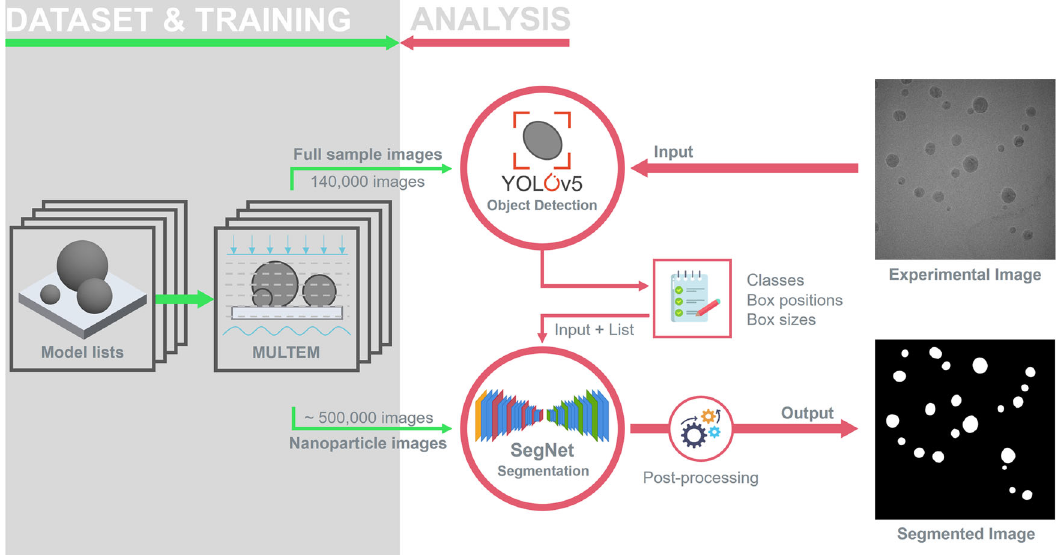
Fig. 1 Work fl ow illustrating the training and inference stages of nNPipe. Training dataset generation is highlighted by green arrows: Au/Ge and Pd/C model computation, simulated training dataset generation 46 – 49 and individual network training of YOLOv5x and SegNet 41 for object detection and semantic segmentation, respectively. Red arrows highlight the inference stage, where an input image (in this case, an example of Au/Ge) is fi rst inferred by object detection and instances of nanoparticles are subsequently semantically segmented as 256 × 256 sub- images by SegNet. The fi nal post-processing stage reconstructs the label to its original size of 2048 × 2048 pixels. **